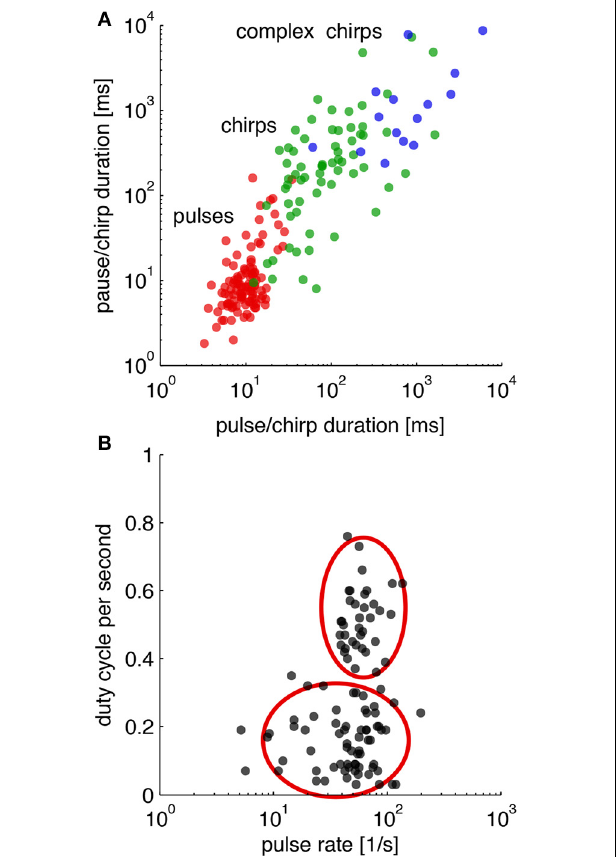
FIGURE 5 | Temporal parameters in the songs of crickets. (A) Distribution of temporal parameters in the calling song for crickets on different time scales. (B) Distribution of calling songs in a 2-dimensional feature space (duty cycle per second refers to the normalized integral i.e., the energy of the song envelope). Cricket songs exhibit mostly lower or higher energy equivalent to songs with short chirps and long trills (red ellipsoids). Calling songs of 106 species of crickets from http://entnemdept . ufl . edu/walker/buzz/cricklist . htm. Song recordings were rectified and low-pass filtered (200Hz) to compute a smooth envelope. Temporal measures such as pulse and chirp durations and pauses were obtained by a threshold function (see Grobe et al., 2012, for